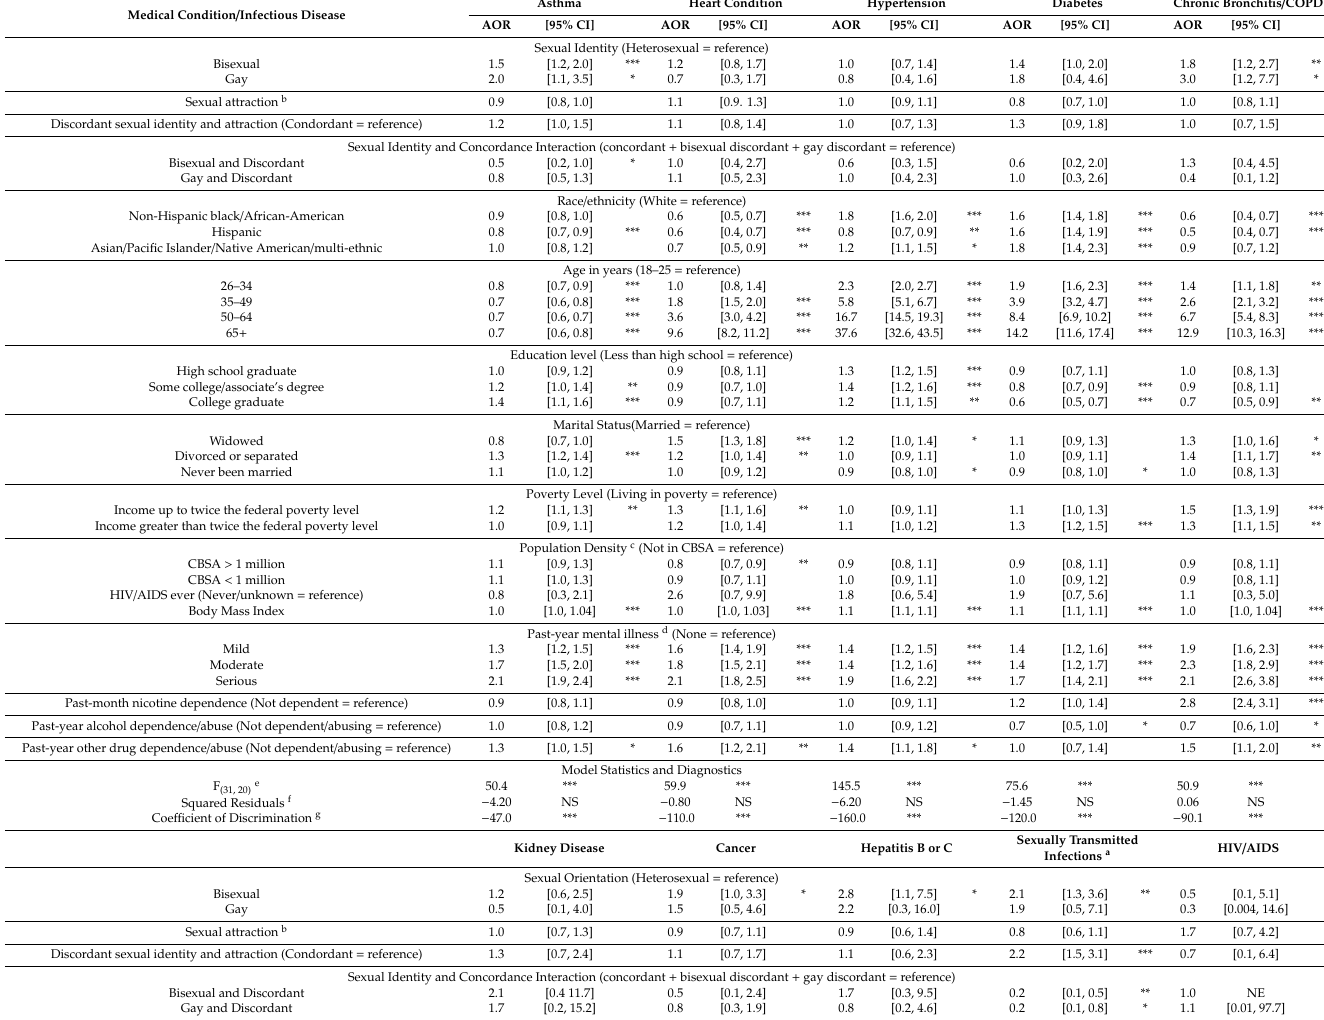
Table 3. Bivariate Logistic Regression Results for Medical Conditions and Infectious